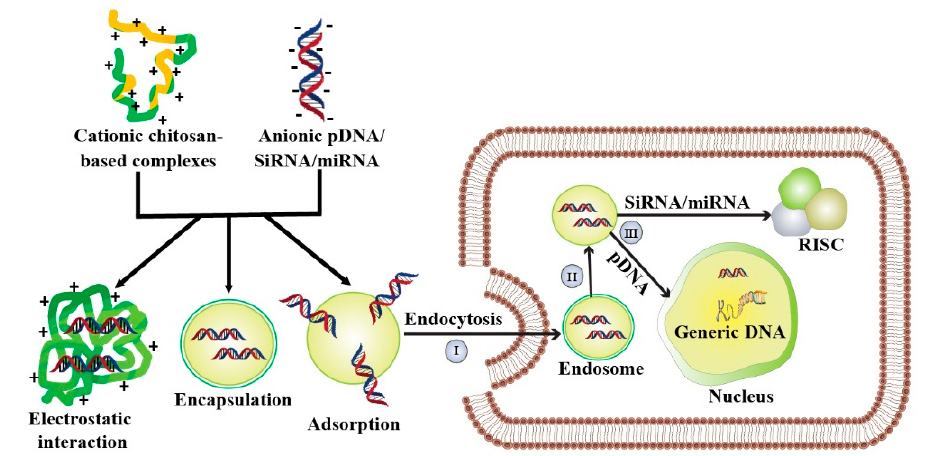
Figure 2. Fabrication strategy and transfection mechanism of chitosan-based nucleic acids carrier. Cationic chitosan interacts with the anionic nucleic acids (i.e., pDNA, siRNA, and miRNA) to formulate complexes for gene delivery. Three main fabrication processes of chitosan-based complexes are (1) Polyplex formation, (2) Encapsulation via ionic gelation method, and (3) Adsorption. The chitosan-based vectors are taken up by endocytosis (I), followed by an escape from endosome (II). After releasing from endosome (III), siRNA and miRNA bind to the RNA-induced silencing complex (RISC) to trigger the RNA interfering (RNAi) pathway. The pDNA is translocated to the nucleus and subsequently performs desired anticancer activity.